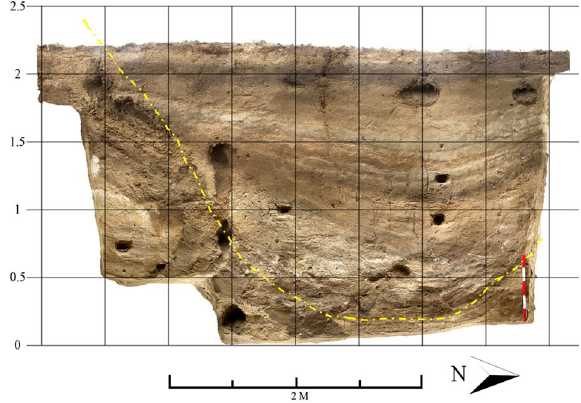
Fig. 4 A pro fi le section through the ditch feature of the wall-system, excavated near Cluster no. 24 (Photo and processing by Tal Rogovski). The yellow line marks the approximate outline of the